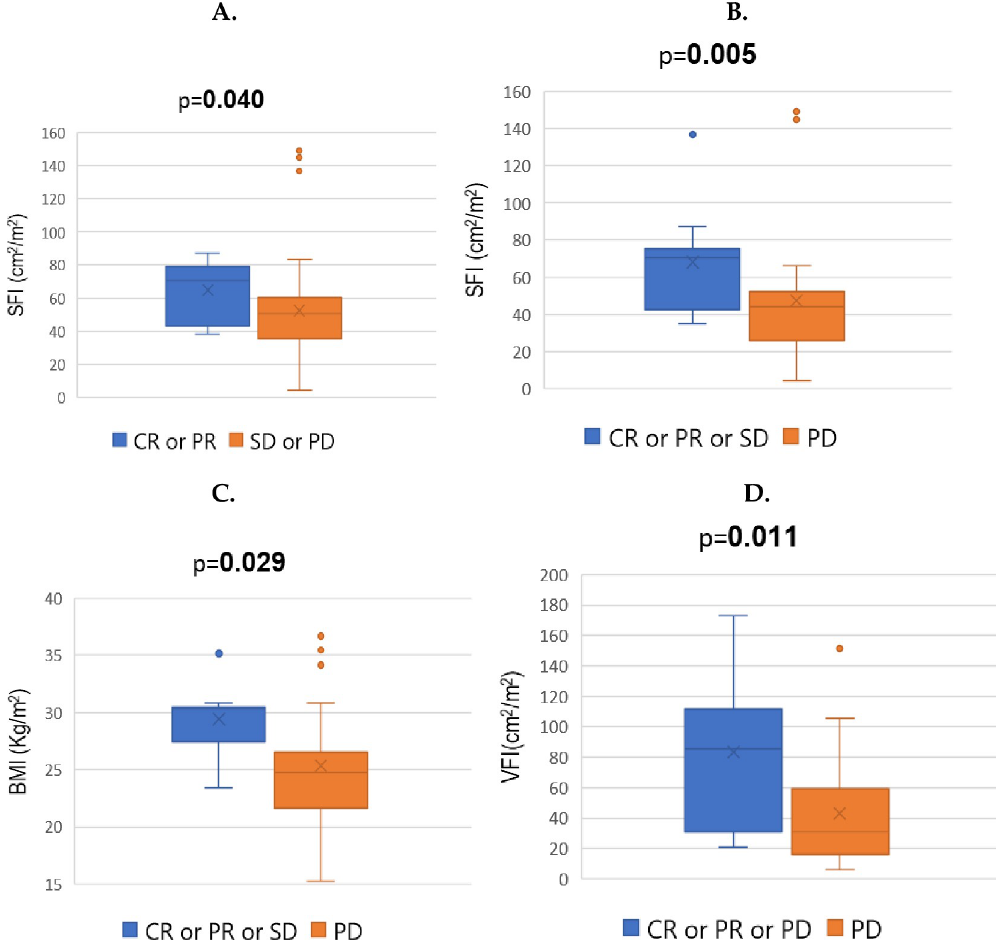
Fig 2. Box-plots depicting the baseline � differential distributions (Mann Whitney U test) of A. SFI (cm 2 /m 2 ) between responders (CR or PR) and non-responders (SD or PD) to I-O B. SFI (cm 2 /m 2 ) between patients who achieved disease control (CR or PR or SD) as result of I-O versus those who developed disease progression (PD) C. BMI (kg/m 2 ) between patients who achieved disease control as result of I-O administration in comparison to those who developed disease progression and D. VFI (cm 2 /m 2 ) between individuals who experienced disease control under I-O versus those who had disease progression. Abbreviations: I-O = Immunotherapy; BMI = Body mass index; VFI = Visceral Fat Index (At the level of 3 rd lumbar vertebra); SFI = Subcutaneous Fat Index (At the level of 3 rd lumbar vertebra); CR = Complete response; PR = Partial response; SD = Stable disease, PD = Progressive disease. � Baseline = At the beginning of immunotherapy. the univariate analysis for OS baseline LSMI < LNL HR = 2.90 (95% CI:1.261–6.667, p =